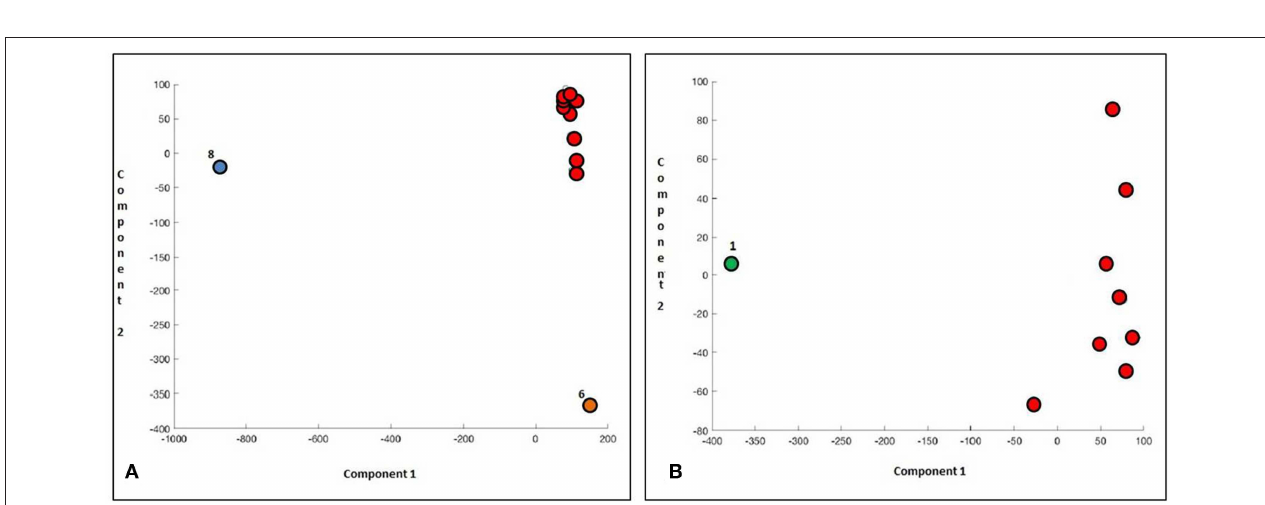
FIGURE 3 | PcGs significantly de-regulation. Optimal responders in blue columns and failing patients in red. De-regulation of some polycomb genes was related to the clinical response, with a significantly up-regulation of PHC3 and worse response to TKIs ( p = 0.03).